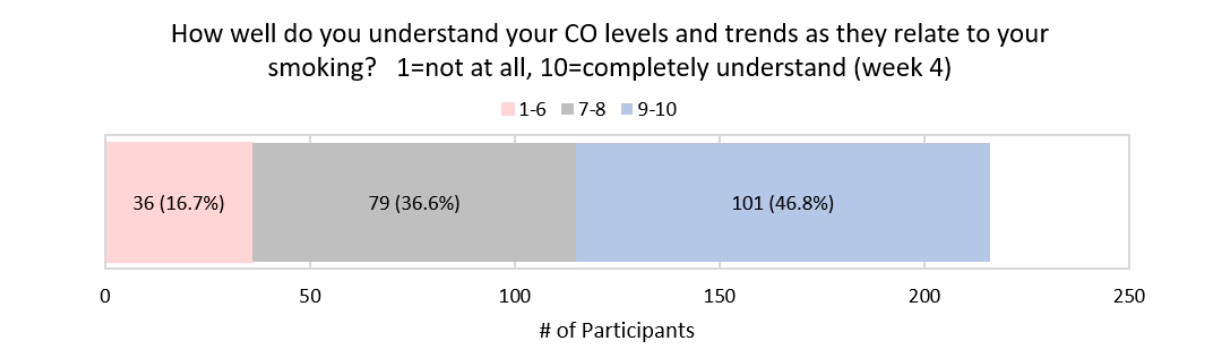
weeks (Figure 14). Overall, a total of 48,747 breath samples were taken over the course of the study with each participant performing a mean of 208.3 (SD 141.8) total breath